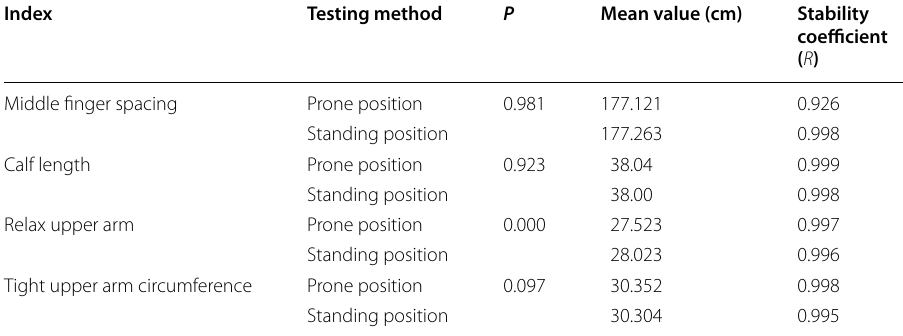
Table 2 Experimental results of two test methods for middle finger distance, calf length, and upper arm